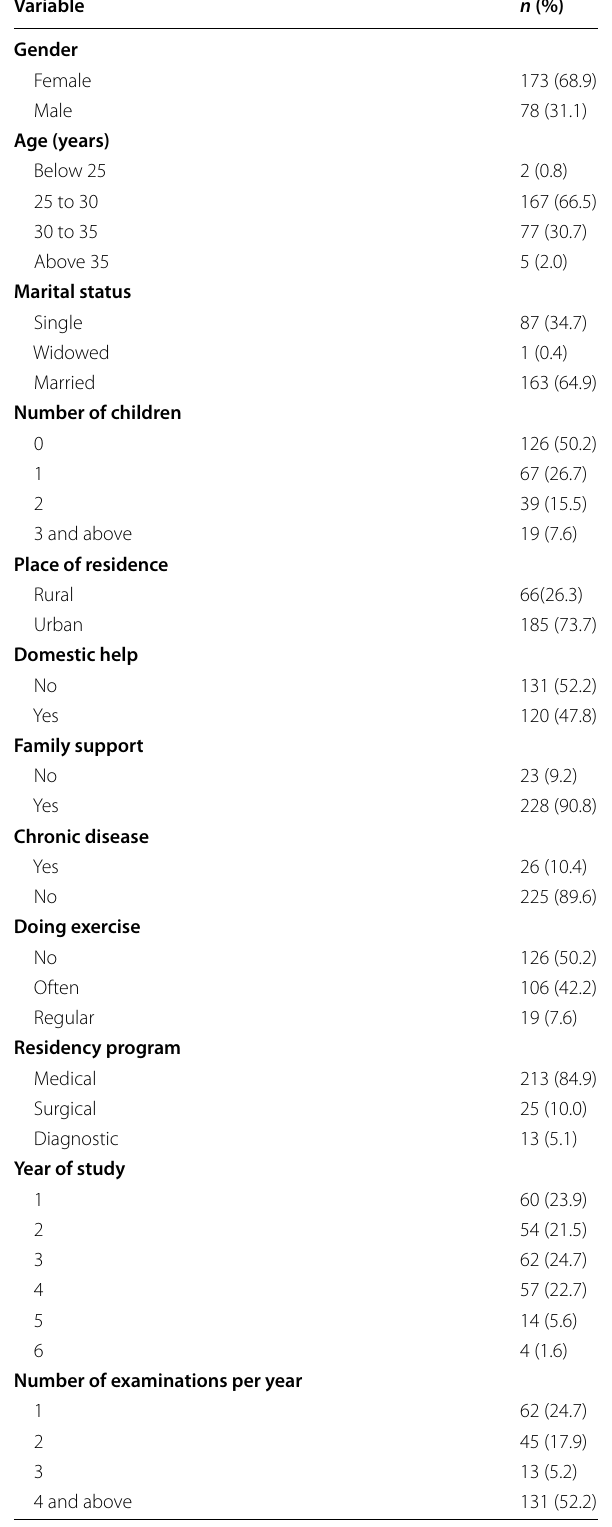
Table 1 Socio‑demographic and occupational variables of